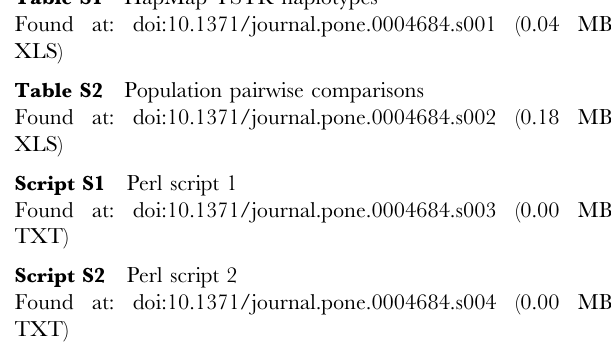
Figure 3. Geographical distributions of regional populations analysed with Y-STRs. A. East Asia; filled circles represent populations that are not significantly different from the CHB. B. Europe; filled circles represent populations that are not significantly different from the